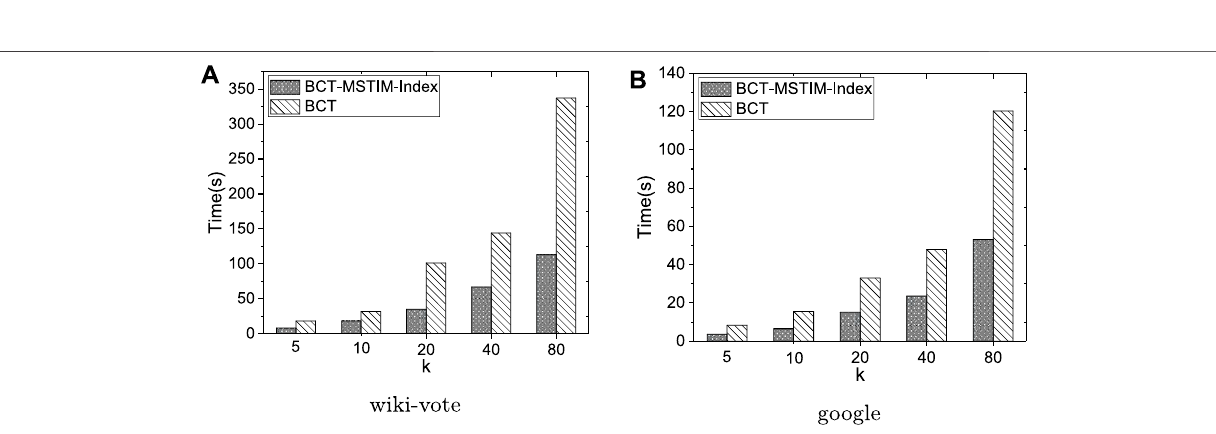
Frontiers in Physics |